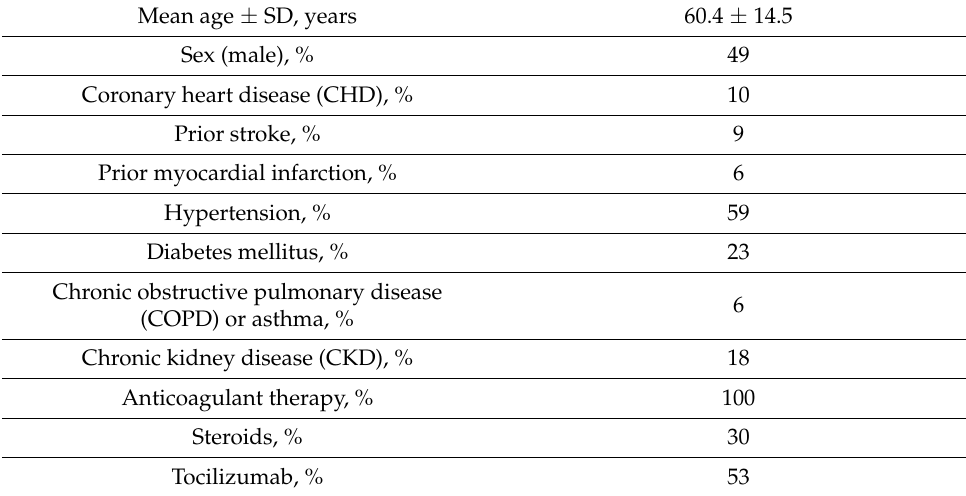
Table 10. Clinical characteristics of